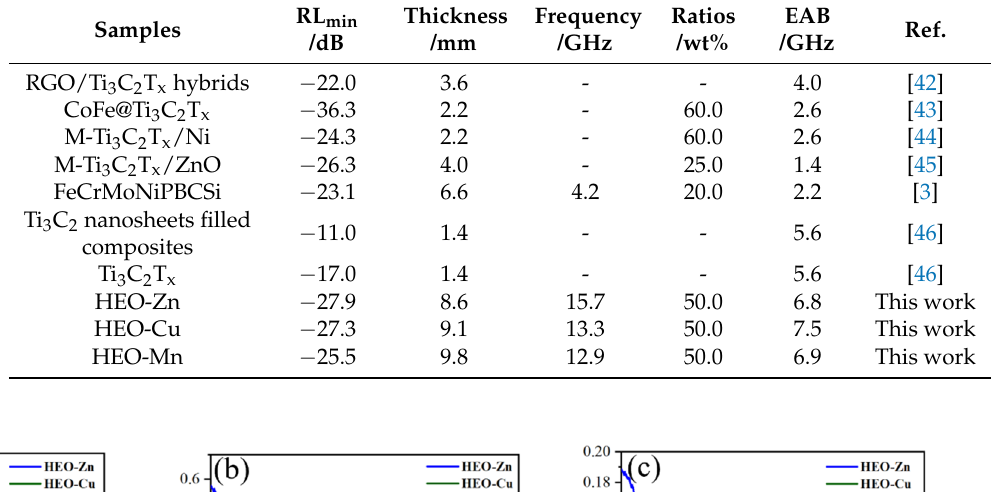
Table 2. The wave absorbing properties including RL min , matching thickness, and EAB values of the present three ferrite samples, as well as many reported EM absorbing materials.